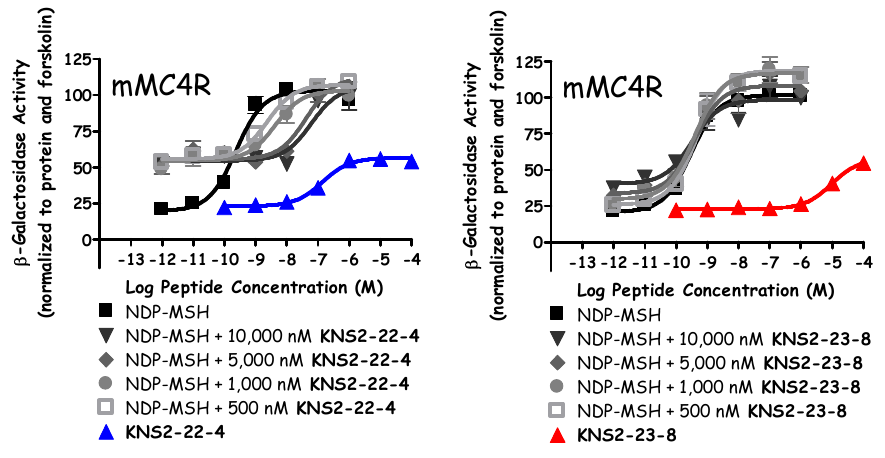
Figure 3. Illustration of the antagonist pharmacology of KNS2-22-4 and KNS2-23-8 at the mMC4R.